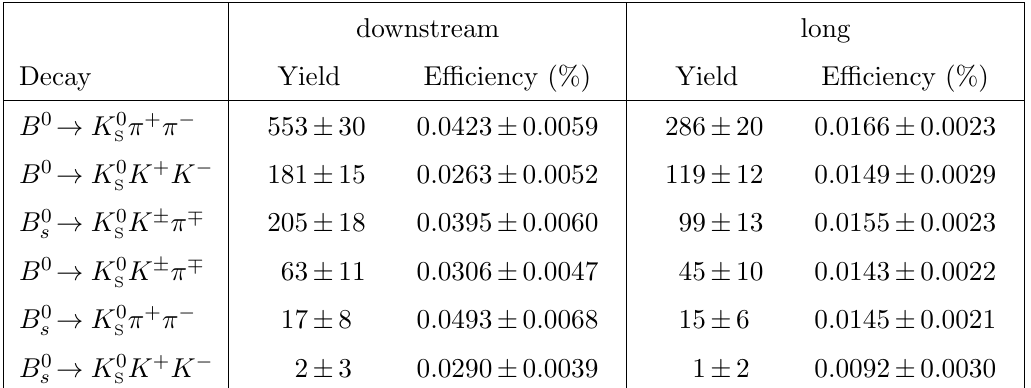
Table 4 . Signal yields obtained for the 2011 category from the simultaneous (cid:12)t to the data. The yields shown are those obtained when (cid:12)tting the data sample selected using the BDT optimisation chosen for the given decay mode. The uncertainties are statistical only. The average selection e(cid:14)ciencies, described in section 5, are also shown for each decay mode together with the corre- sponding total uncertainty due to the limited simulation sample size and systematic e(cid:11)ects in their determination.